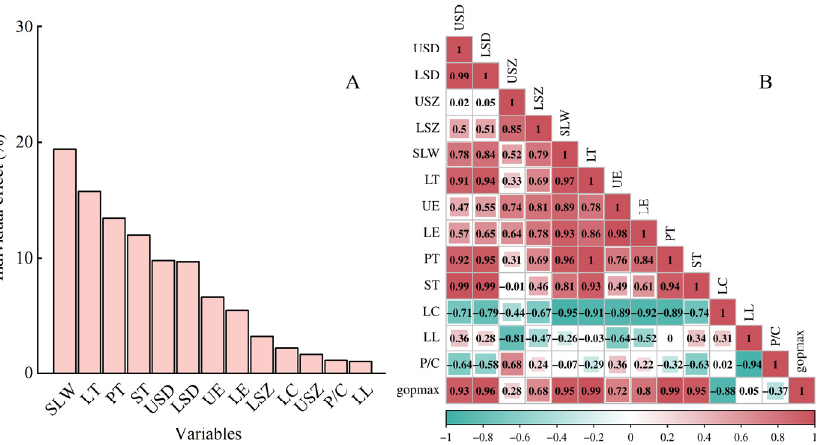
Figure 6. The relative importance of individual variables on g opmax and the correlation between g opmax and influence variables. ( A ) The contribution value analysis; ( B ) the correlation analysis. Blue indicates a passive correlation, and red shows a positive correlation. The darker color indicates a more robust correlation. Note: g opmax —maximum operational stomatal conductance; LC—leaf tissue compactness; LET—lower epidermal cell thickness; LT—leaf thickness; LL—leaf tissue